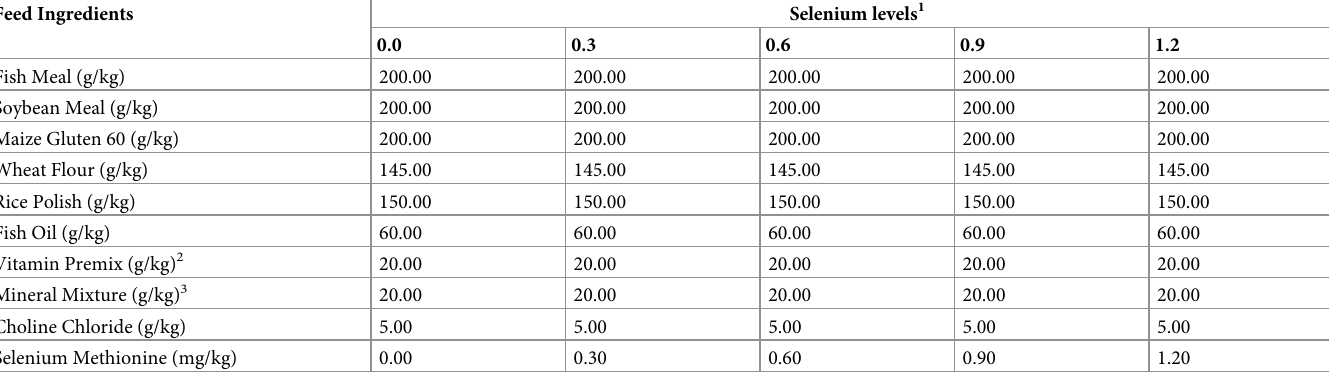
Table 1. Diets formulation and levels of Se methionine supplementation on a dry basis.